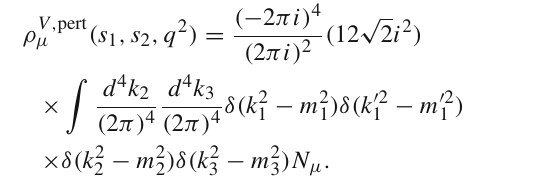
Fig. 3 The perturbative contribution to transition form factors. The doubly-solid line denotes a heavy quark, and the ordinary solid line corresponds to a light